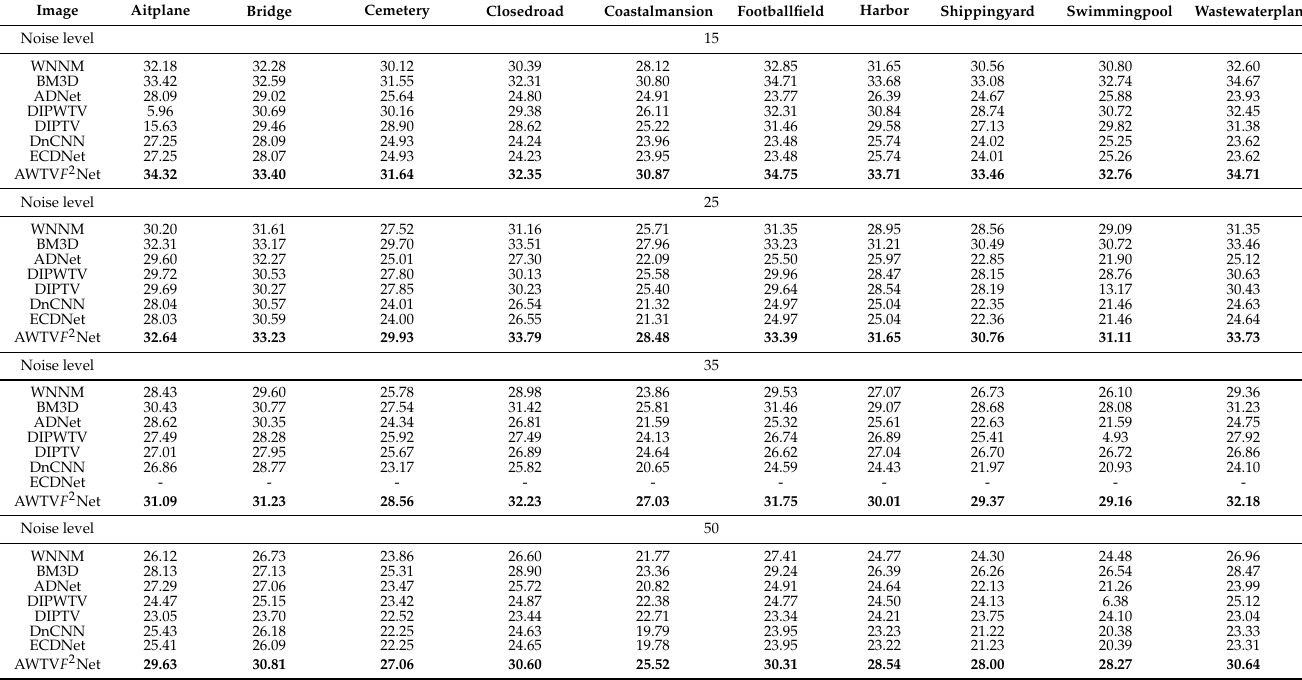
Table 3. PSNR results of different methods for each calss from the PatternNet dataset. The bold values denote the best